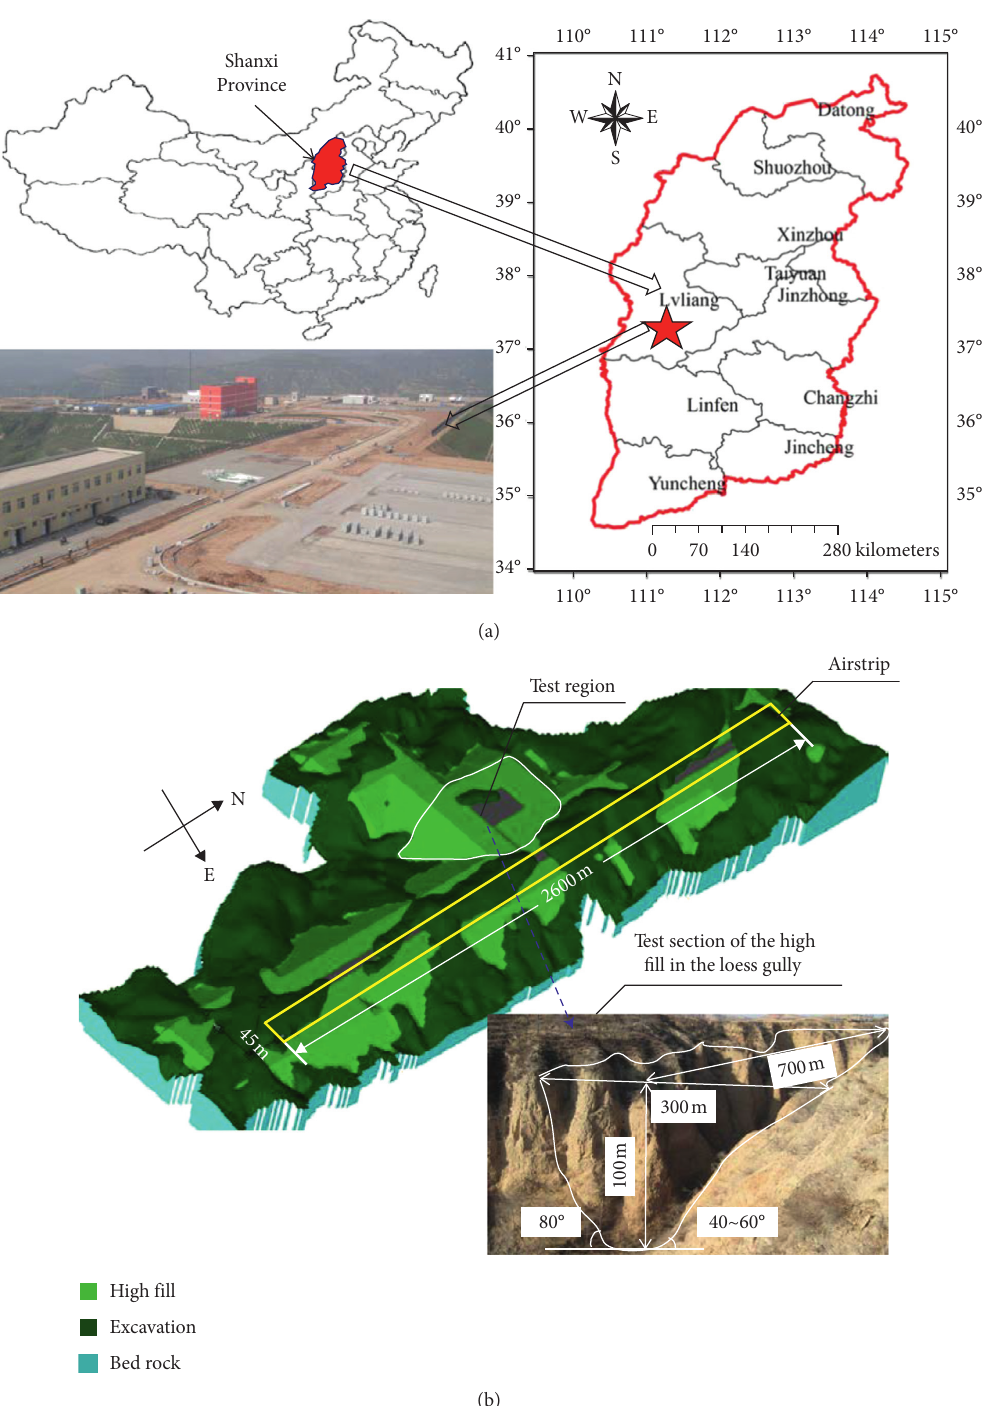
Figure 1: Overview of Lvliang Airport. (a) Geographical location of Lvliang Airport. (b) Profile of the high fill of Lvliang Airport (after